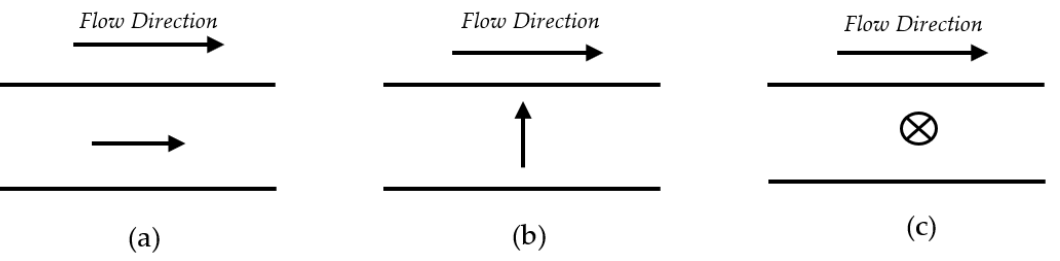
Figure 3. Miesowicz viscosities in the direction of ( a ) velocity, ( b ) velocity gradient, and ( c ) vorti- city.